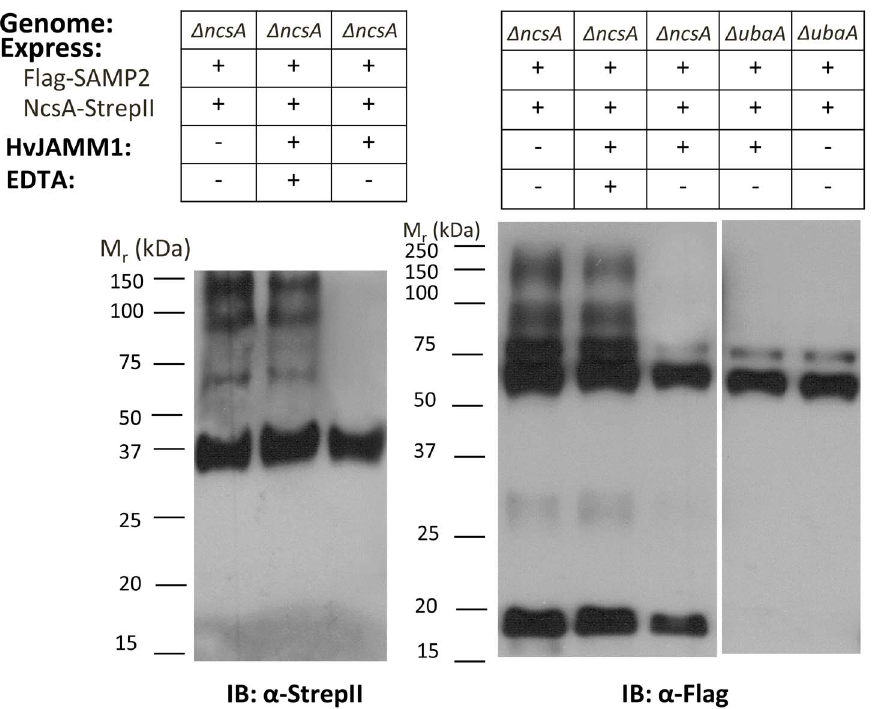
Figure 5. HvJAMM1 (desampylase) collapses SAMP2-NcsA conjugates. NcsA-StrepII fractions were purified from D ncsA and D ubaA strains, incubated with HvJAMM1 in the presence and absence of EDTA, and analyzed by IB as indicated. Molecular weight markers are indicated to the left of each blot. Pull down assays were from 1 L cultures. See Methods section for details.